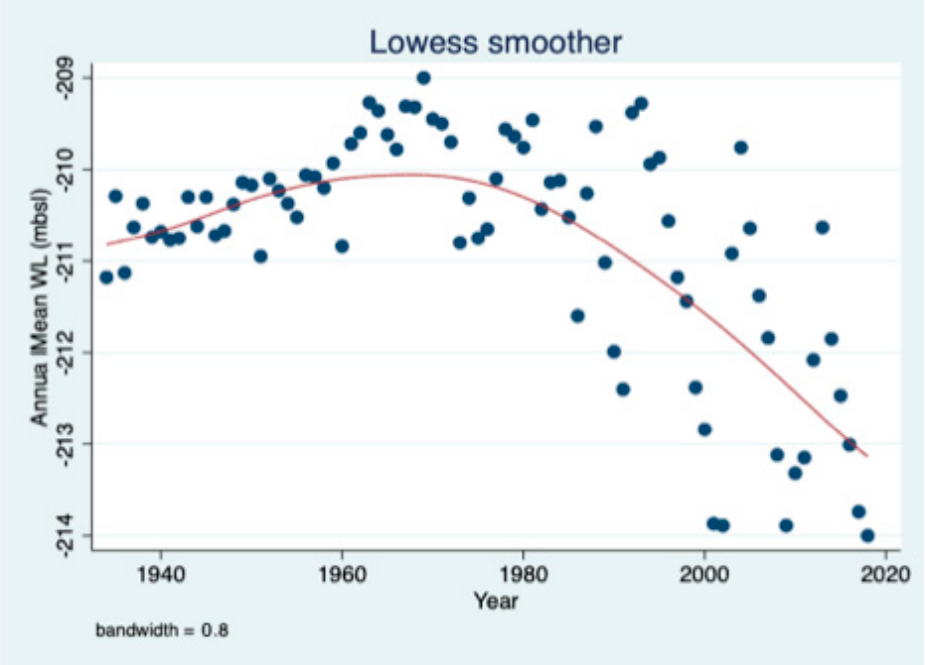
Figure 2. Trend of changes (Lowess smoother) of an annual mean of Lake Kinneret water level (WL). (mbsl) during